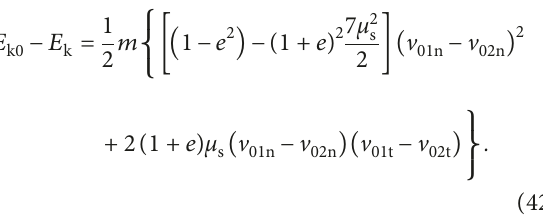
Figure 4: Analysis process of the revised Hertz contact theory considering the tangential